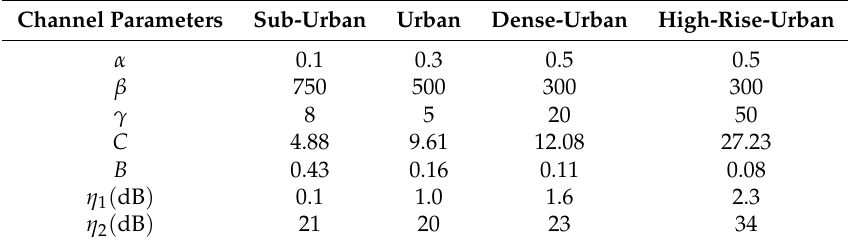
Table 2. Channel Parameters in different urban